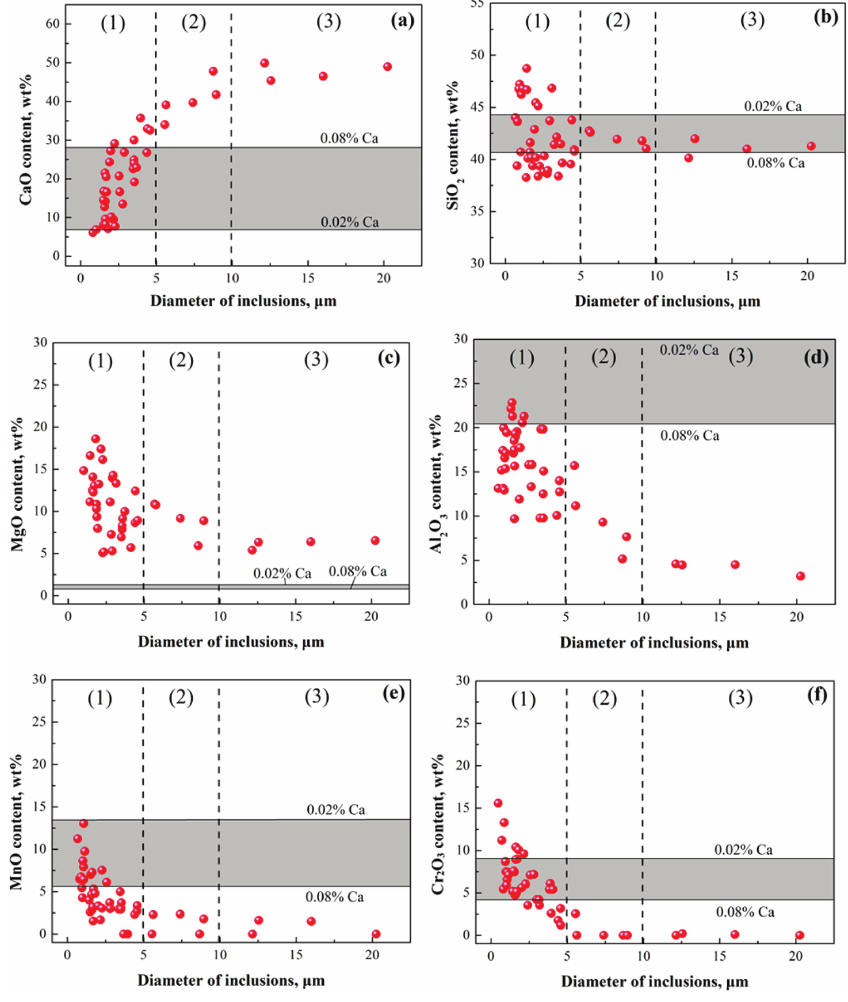
Figure 4: Comparison of inclusions between measured value and calcu- lated value. (a) CaO, (b) SiO 2 , (c) MgO, (d) Al 2 O 3 , (e) MnO, (f) Cr 2 O 3